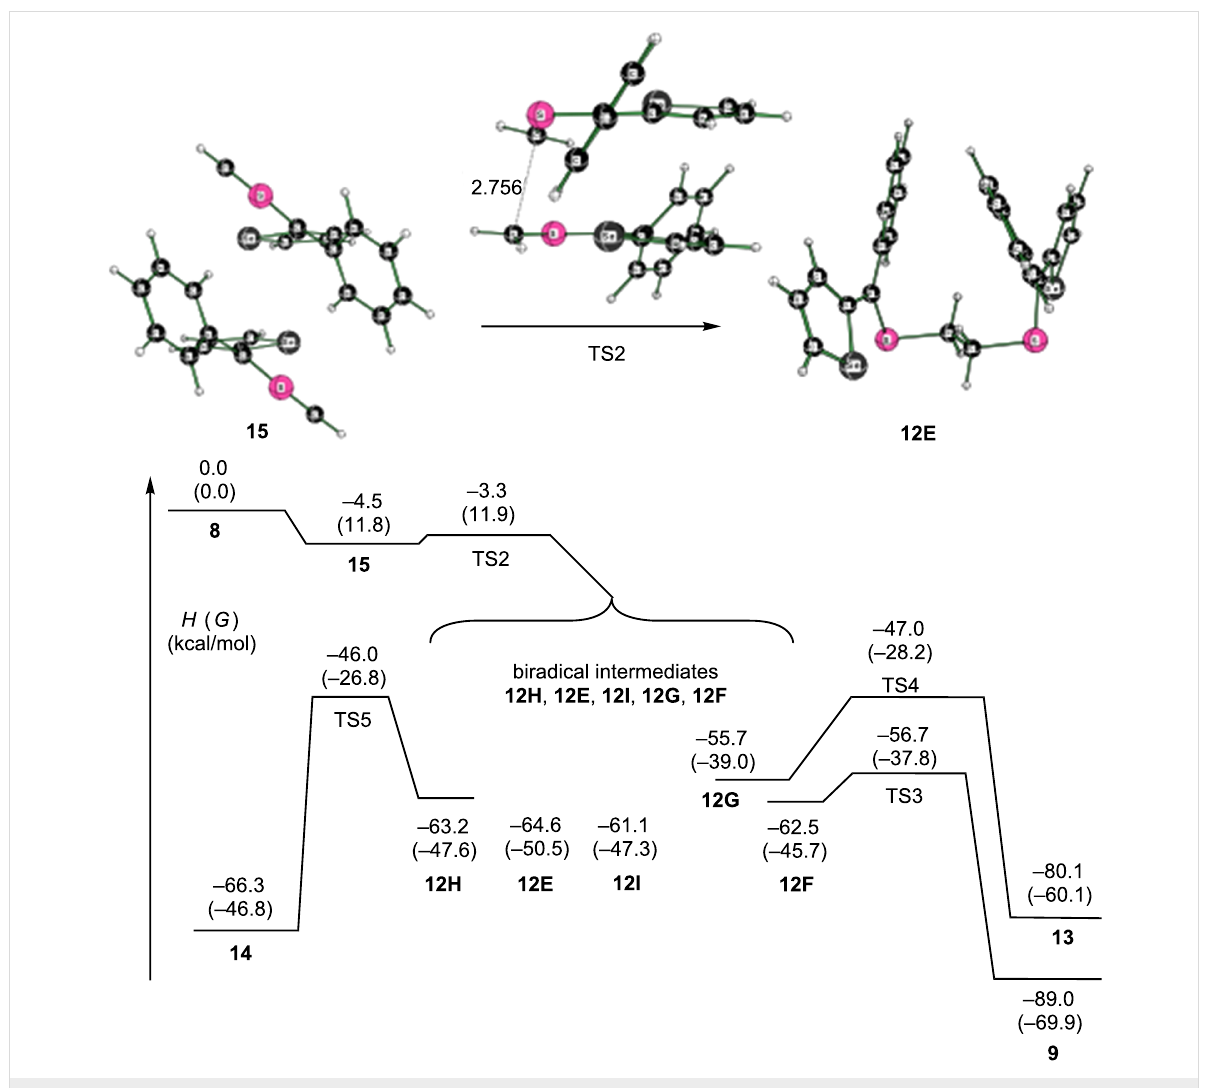
Figure 3: Stepwise radical dimerization of the reactive thiocarbonyl S -methanide 8 . Computed enthalpies (free energies in parentheses) at 298 K at the SMD(tetrahydrofuran)/M06-2X/6-311+G(2df,p)//M06-2X/6-31G(d) level of theory. The species 12E – I are all biradical intermediates in the reaction mechanism and should be able to interconvert